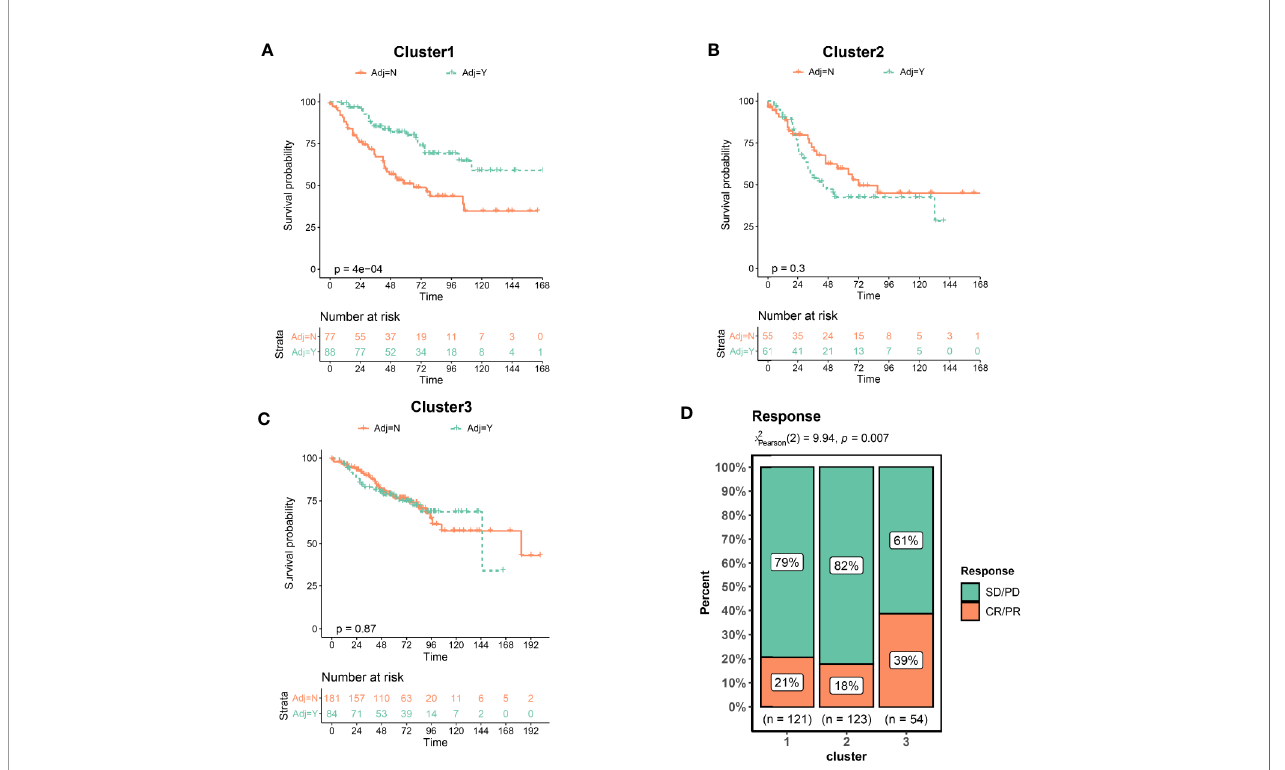
FIGURE 4 | Clusters predicts therapeutic bene fi t of chemotherapy and immunotherapy. (A) Kaplan – Meier curves of overall survival for patients in Cluster1 strati fi ed by receipt of adjuvant chemotherapy. (B) Cluster2. (C) Cluster3. (D) Response rate of patients to immunotherapy. CR, complete response; PR, partial response; SD, stable disease; PD, progressive